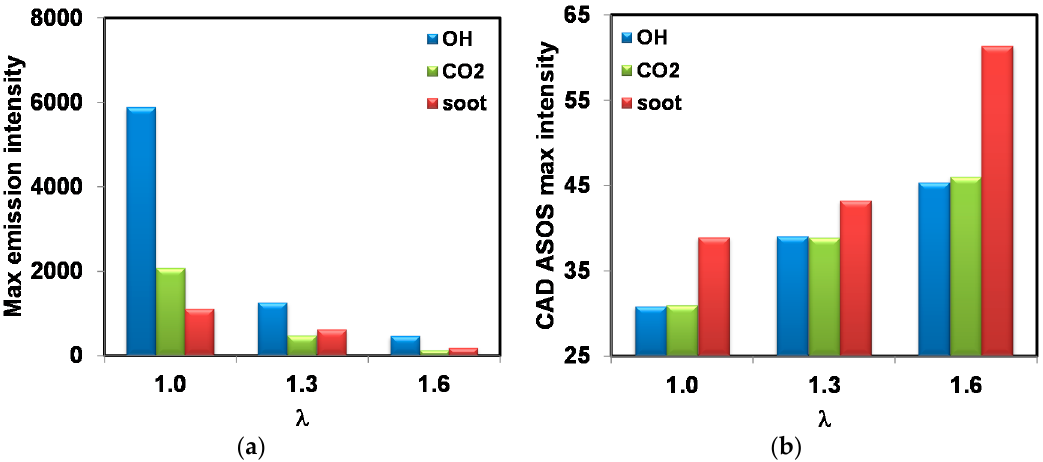
Figure 20. Maximum emission intensity ( a ) and delay from the spark timing of the maximum emission intensity ( b ) measured in the combustion chamber from spectroscopic investigations for OH, CO 2 , and soot.